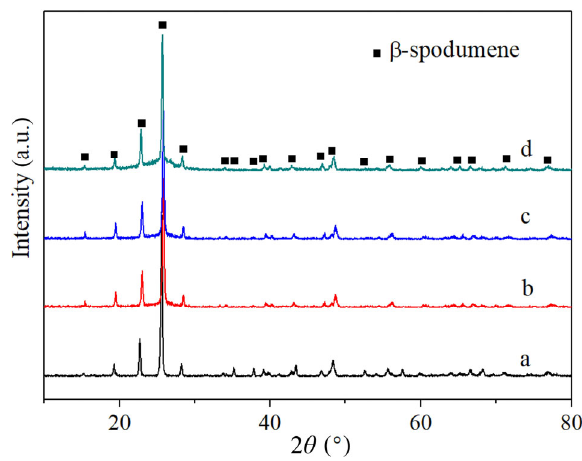
Fig. 3 XRD patterns of LAS and C f /LAS composites with different carbon fiber content: (a) LAS glass-ceramics, (b) 33 vol% carbon fiber, (c) 37 vol% carbon fiber, and (d) 45 vol% carbon